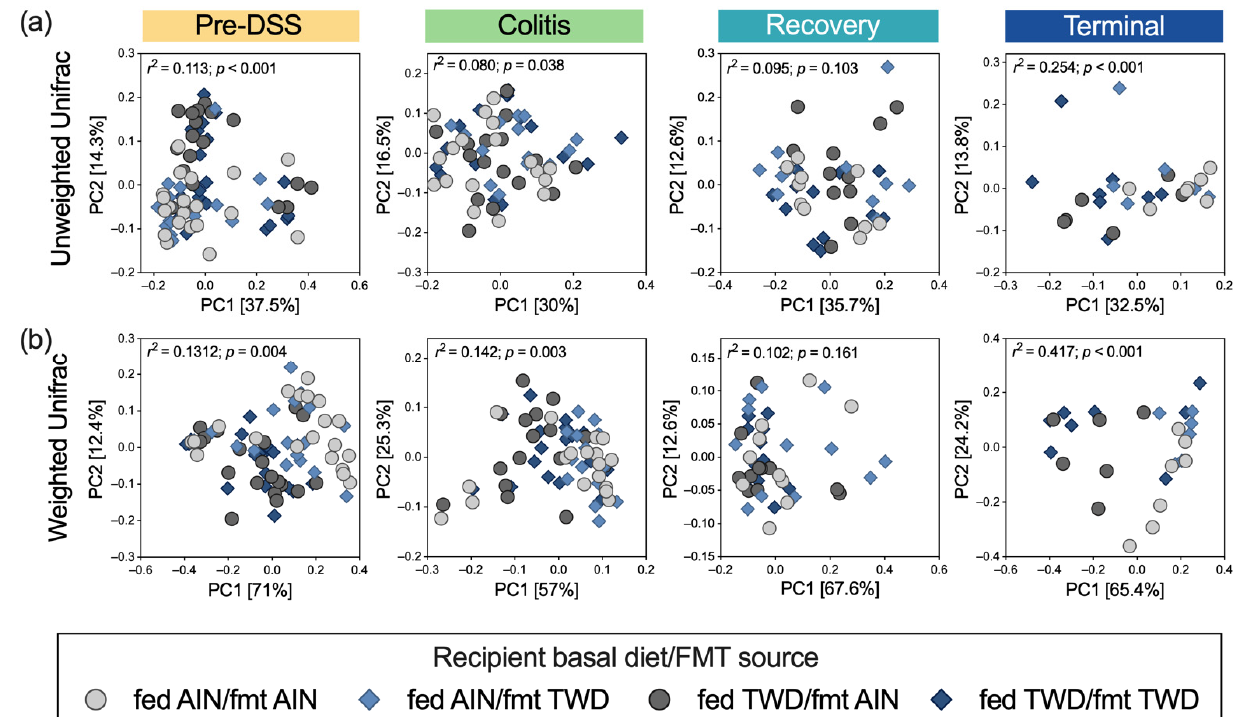
Figure 11. Beta diversity of mouse fecal microbiomes at each experimental time point. The principal coordinate plots depicting fecal microbiome beta diversity using ( a ) unweighted or ( b ) weighted unifrac distances are shown using the first two components ( n = 19 to 20 cages per group at the pre-DSS time point, n = 17 to 18 cages per group at the active colitis time point, n = 12 to 13 cages per group at the recovery time point, and n = 7 to 8 cages per group at the terminal time point). The variations attributed to PC1 and PC2 are shown, along with the r 2 and permanova p -values for each plot.